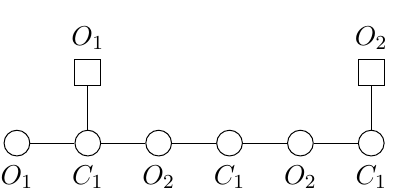
Figure 70. Quiver obtained from brane system in the third row of table 6. Its Higgs branch is M H = A 5